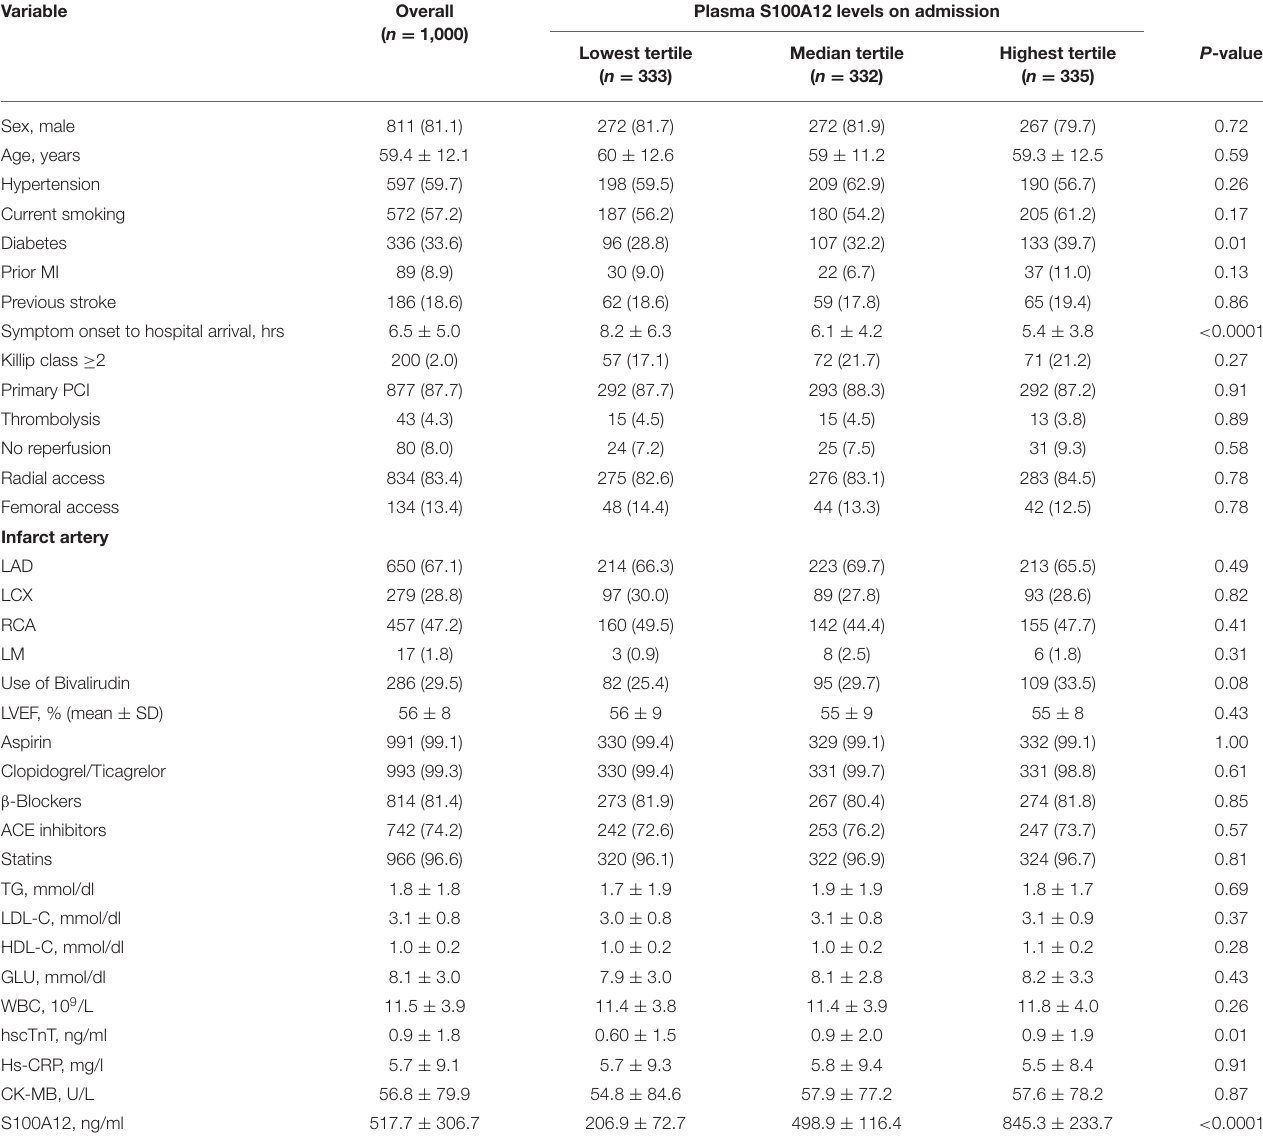
TABLE 2 | Baseline characteristics of cohort 3 STEMI patients stratified by baseline S100A12 tertiles. Variable